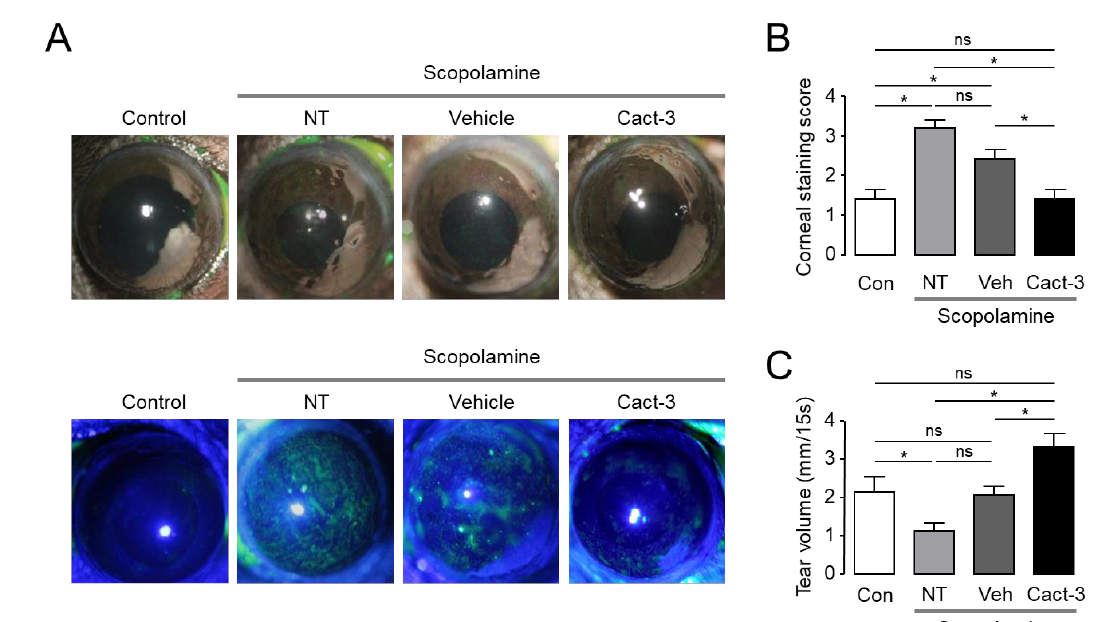
Figure 5. Cact-3 reduced ocular surface damage and increased tear volume in a scopolamine-induced dry eye mouse model. ( A ) Representative photographs of mouse eyes ( top ) and corneal fluorescein staining images of mice ( bottom ). Vehicle and Cact-3 were treated 3 times a day for 10 days. ( B ) Summary of corneal fluorescein staining scores (mean ± S.E., n = 5). ( C ) Summary of basal tear volume measured with phenol red thread test (mean ± S.E., n = 8). NT: not treated; ns: not significant. * p < 0.05.